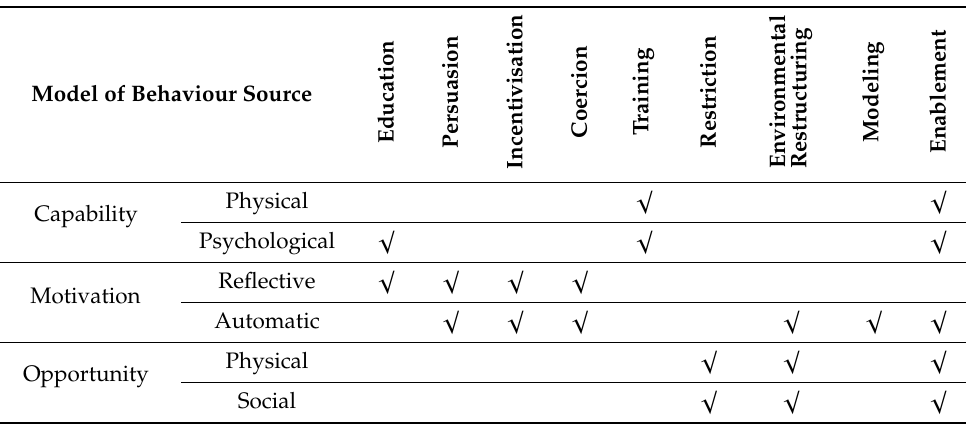
Table 1. The relationship between the components of the ‘COM-B’ model of behaviour (capabilities, opportunities, and motivations) and the nine intervention functions (adapted from Michie et al. [17]). A tick indicates where a particular intervention function could be used to address each component of the